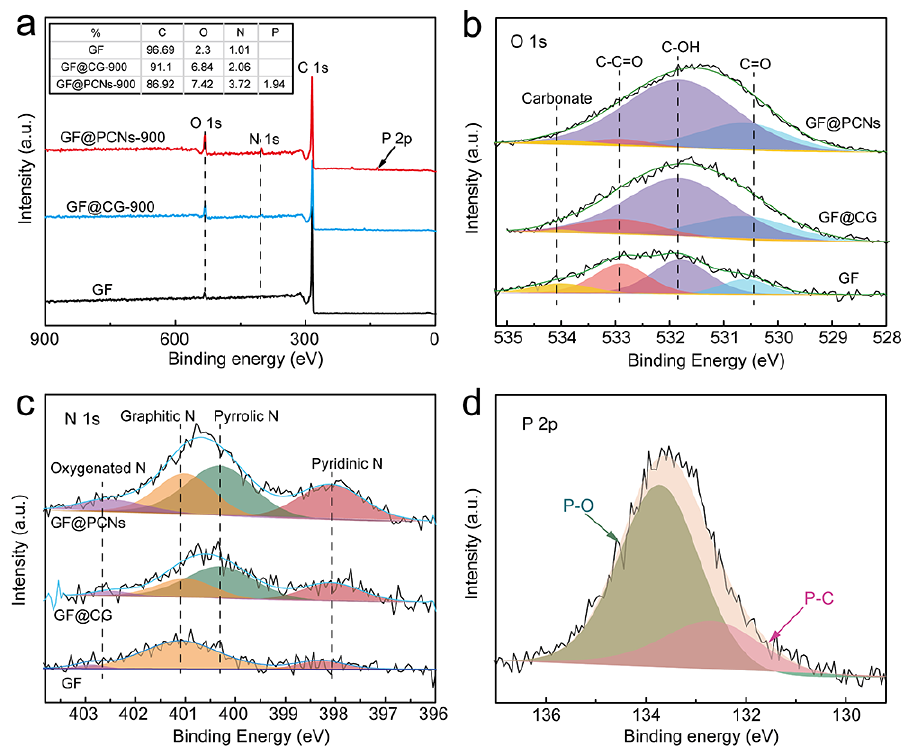
Figure 6. ( a ) XPS survey, ( b ) High-resolution XPS O 1s and ( c ) N 1s spectrum of the GF, GF@CG-900 and GF@PCNs900, ( d ) High-resolution XPS P 2p spectrum of GF@PCNs.